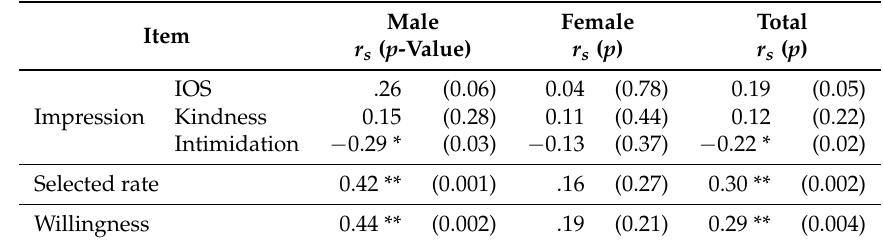
Table 5. Correlation coefficient between amount of self-disclosure and questionnaire items (*: p < 0.05, **: p <